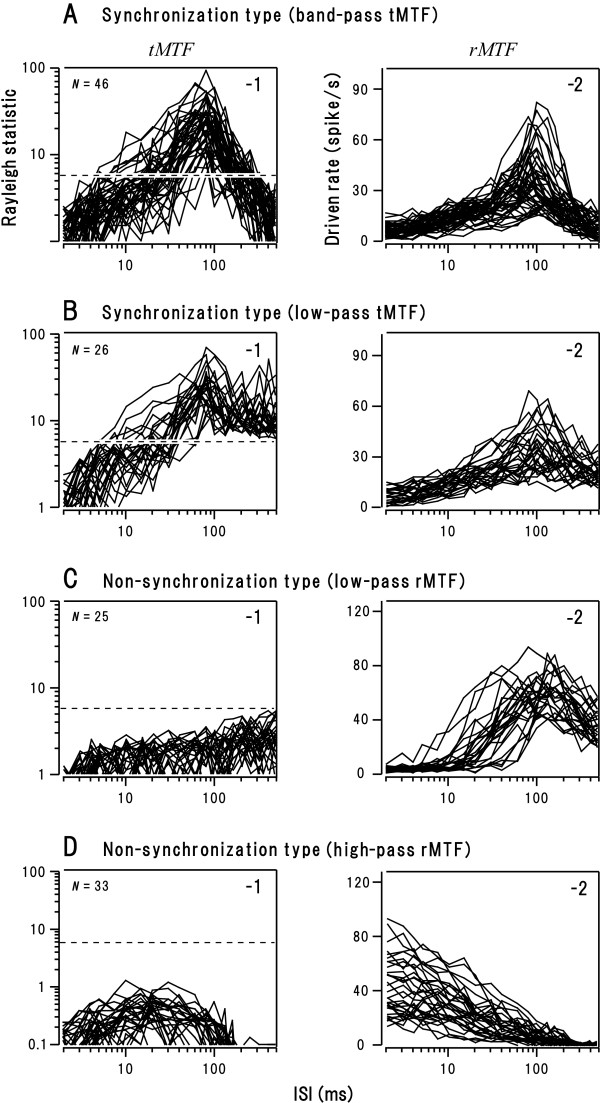
The tMTF (left column) and rMTF (right column) for individual synchronization neurons with band-pass tMTF (A) or low-pass tMTF (B), and for non-synchronization neurons with low-pass rMTF (C) or high-pass rMTF (D). Dotted line: statistically significant level (P = 0.05) for the Rayleigh test. See Figure 1 and text for definition of the response variables.